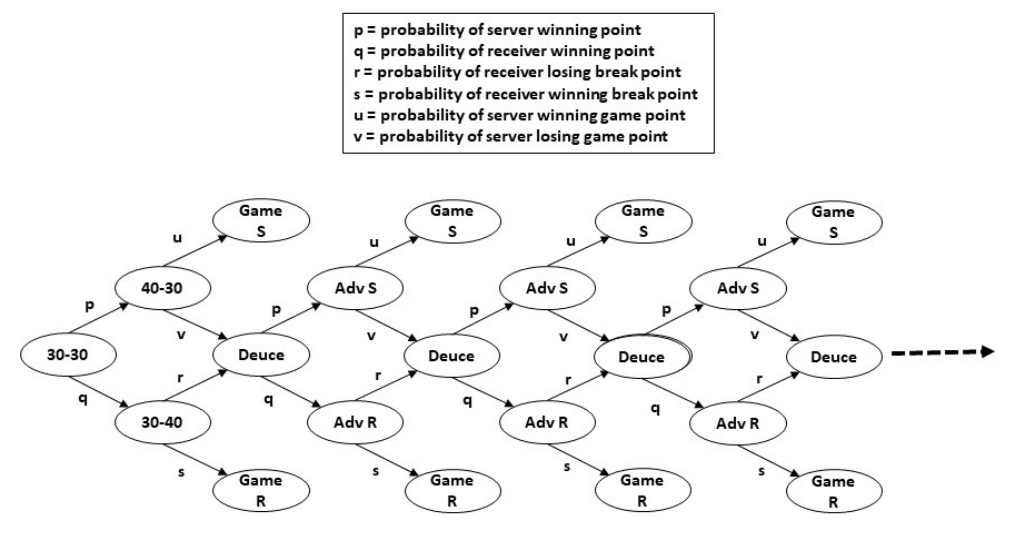
Figure 2. Pathways to winning or losing a Thirty30 tennis